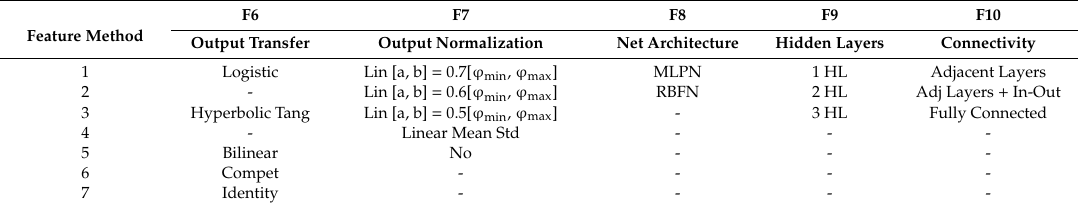
Table 4. ANN features 6 through 10.